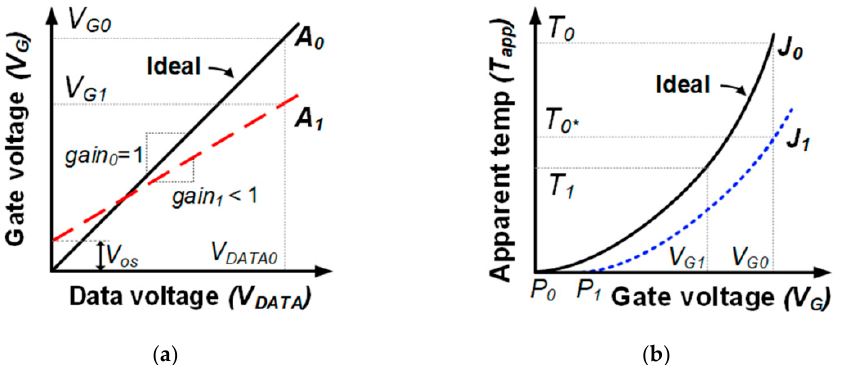
Figure 2. Transfer curves: ( a ) data voltage against gate voltage; ( b ) gate voltage against apparent temperature ( A 1 , J 1 : nonideal curves).